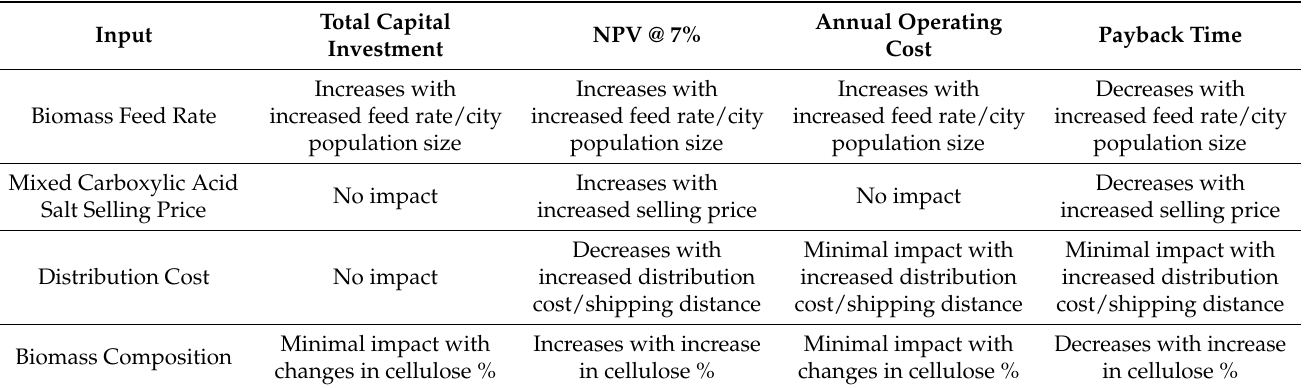
Table 15. Relationship between the critical input factors and process